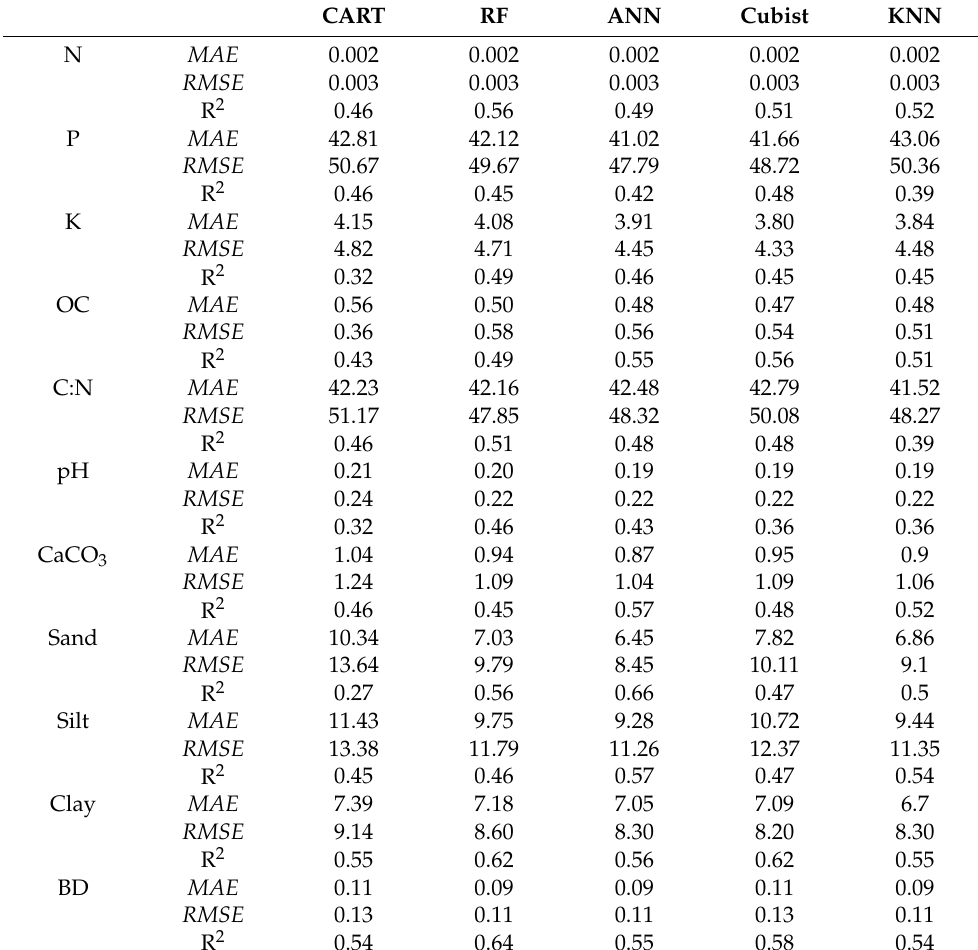
Table 4. Different studied decision models in estimating soil physiochemical properties. CART RF ANN Cubist